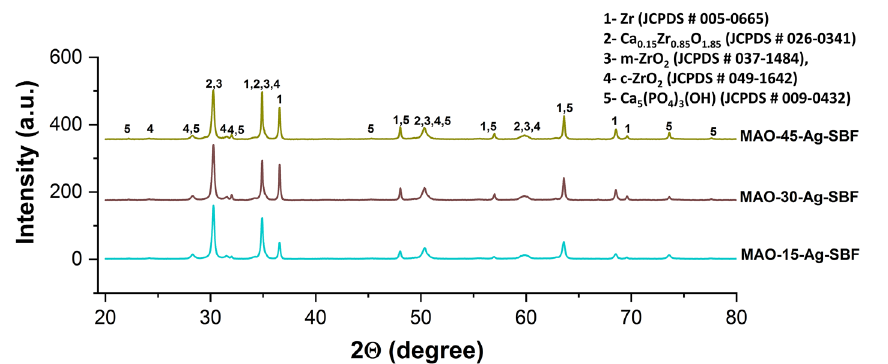
Figure 9. XRD spectra of AgNPs-doped MAO surfaces at post immersion in